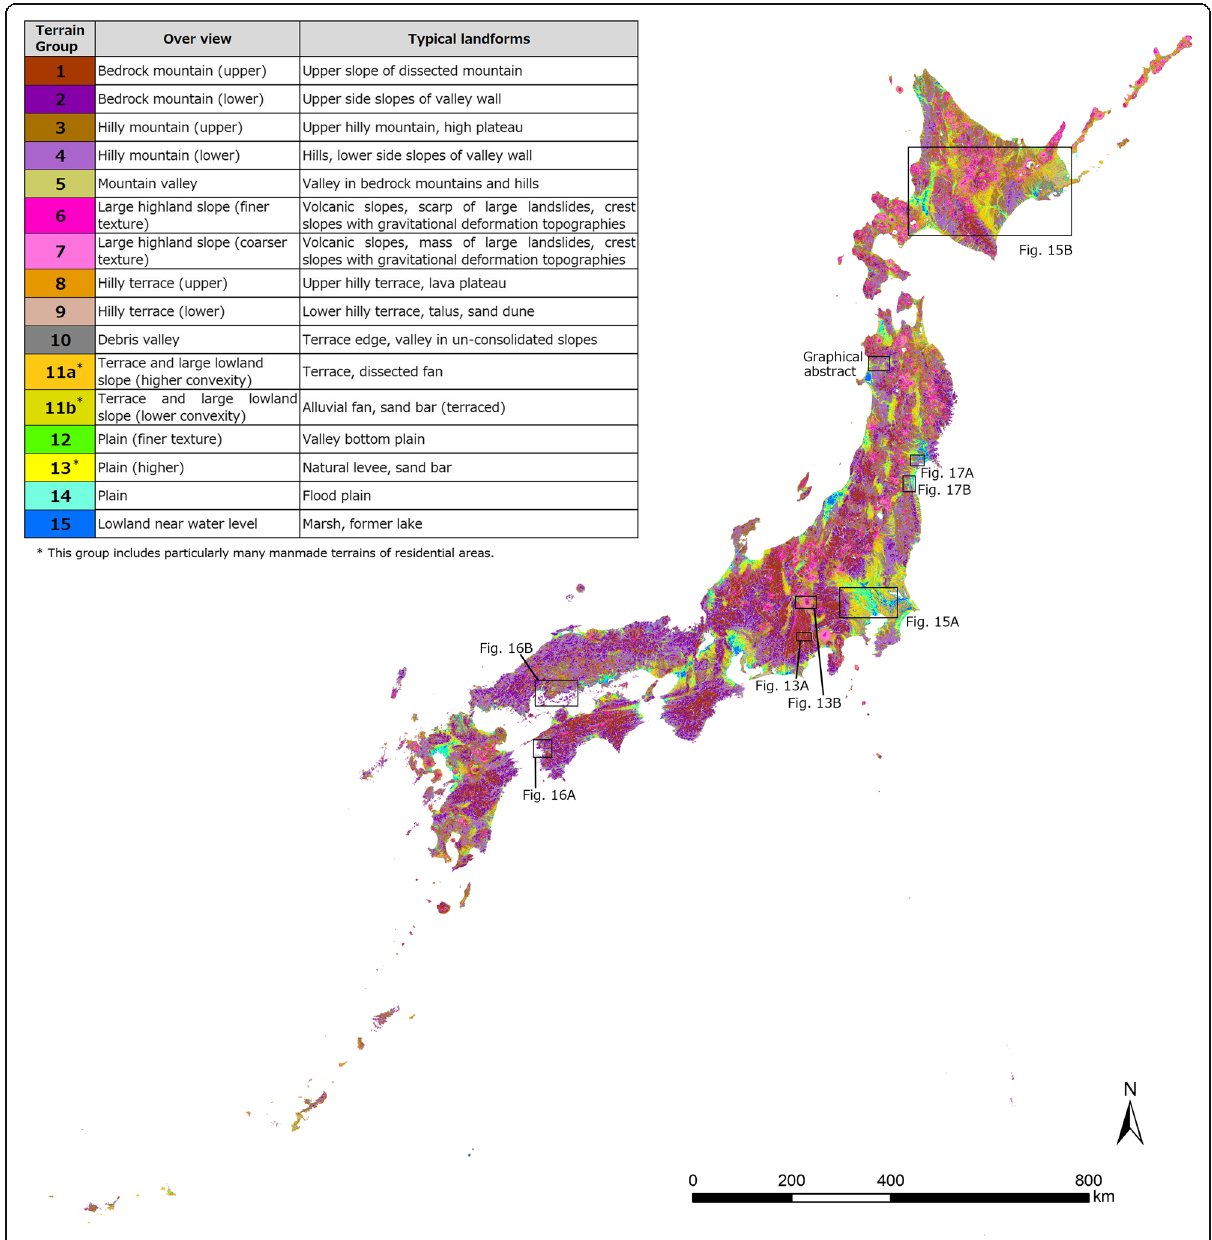
Fig. 14 Overview of the terrain classification of this study. This reference map has been reduced in resolution and does not show remote islands. The original map can be seen from the linked URL (https://gisstar.gsi.go.jp/Japan_terrain/). Black boxes show the locations of Figs. 13, 15, 16, and 17 and the graphical